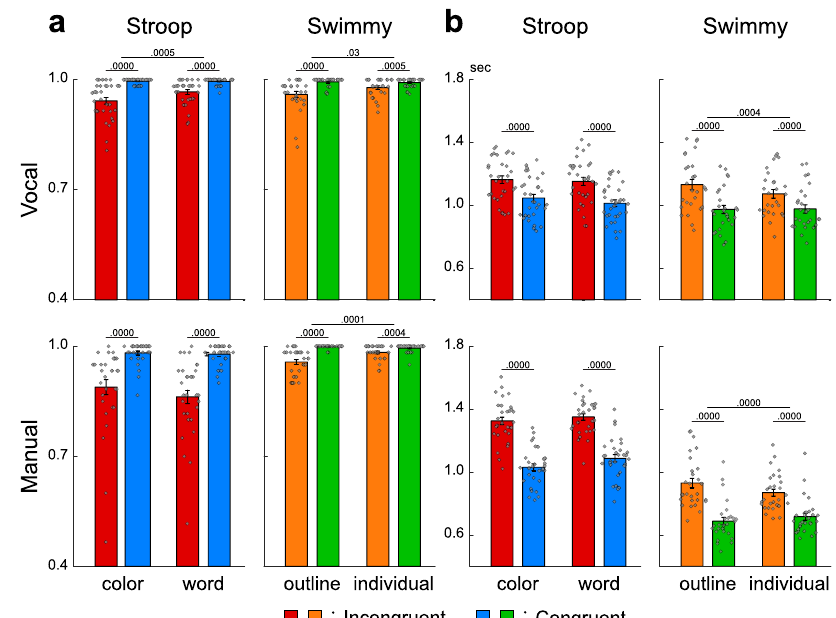
Fig.2|Behavioralresults.a AccuracyintheStroop(left)andSwimmy(right)tasks with vocal (top) and manual (bottom) responses (vocal Stroop: N =32; manual Stroop: N =31; vocal Swimmy: N =27; manual Swimmy: N =28; independent parti- cipants). The vertical and horizontal axes indicate accuracy and conditions (task and congruency), respectively. Rectangular and error bars indicate means and standard errors of the mean across participants, respectively, with individual data